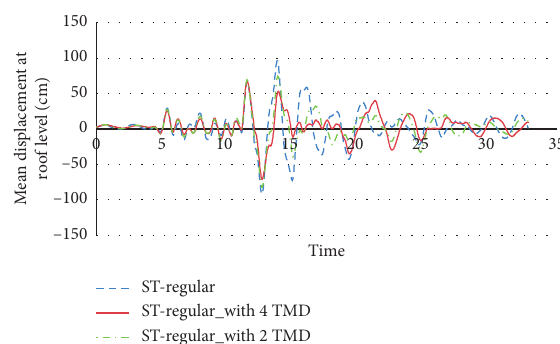
Figure 27: Displacement of the twenty-story regular model with 2 and 4